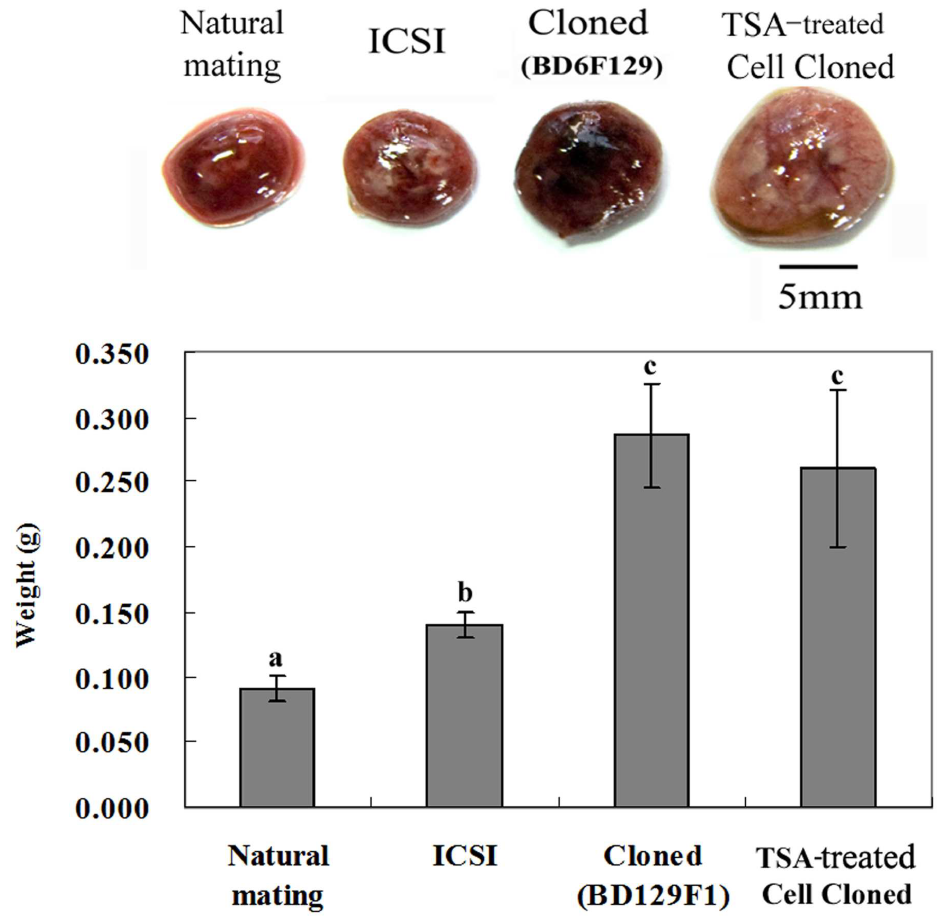
Fig 1. Weights of cloned mouse placentae measuredimmediately after Cesareansection. Size differences betweenNM control, ICSI-derived, cloned, and TSA-treated cloned placentaeare shown. Four placentalsamples per ICSI, cloned, TSA treatment and natural mating were collected.Error bars show the standarderror (SE). Different letters (a-c) above the bars denote statistically significantdifferences (p < 0.05).